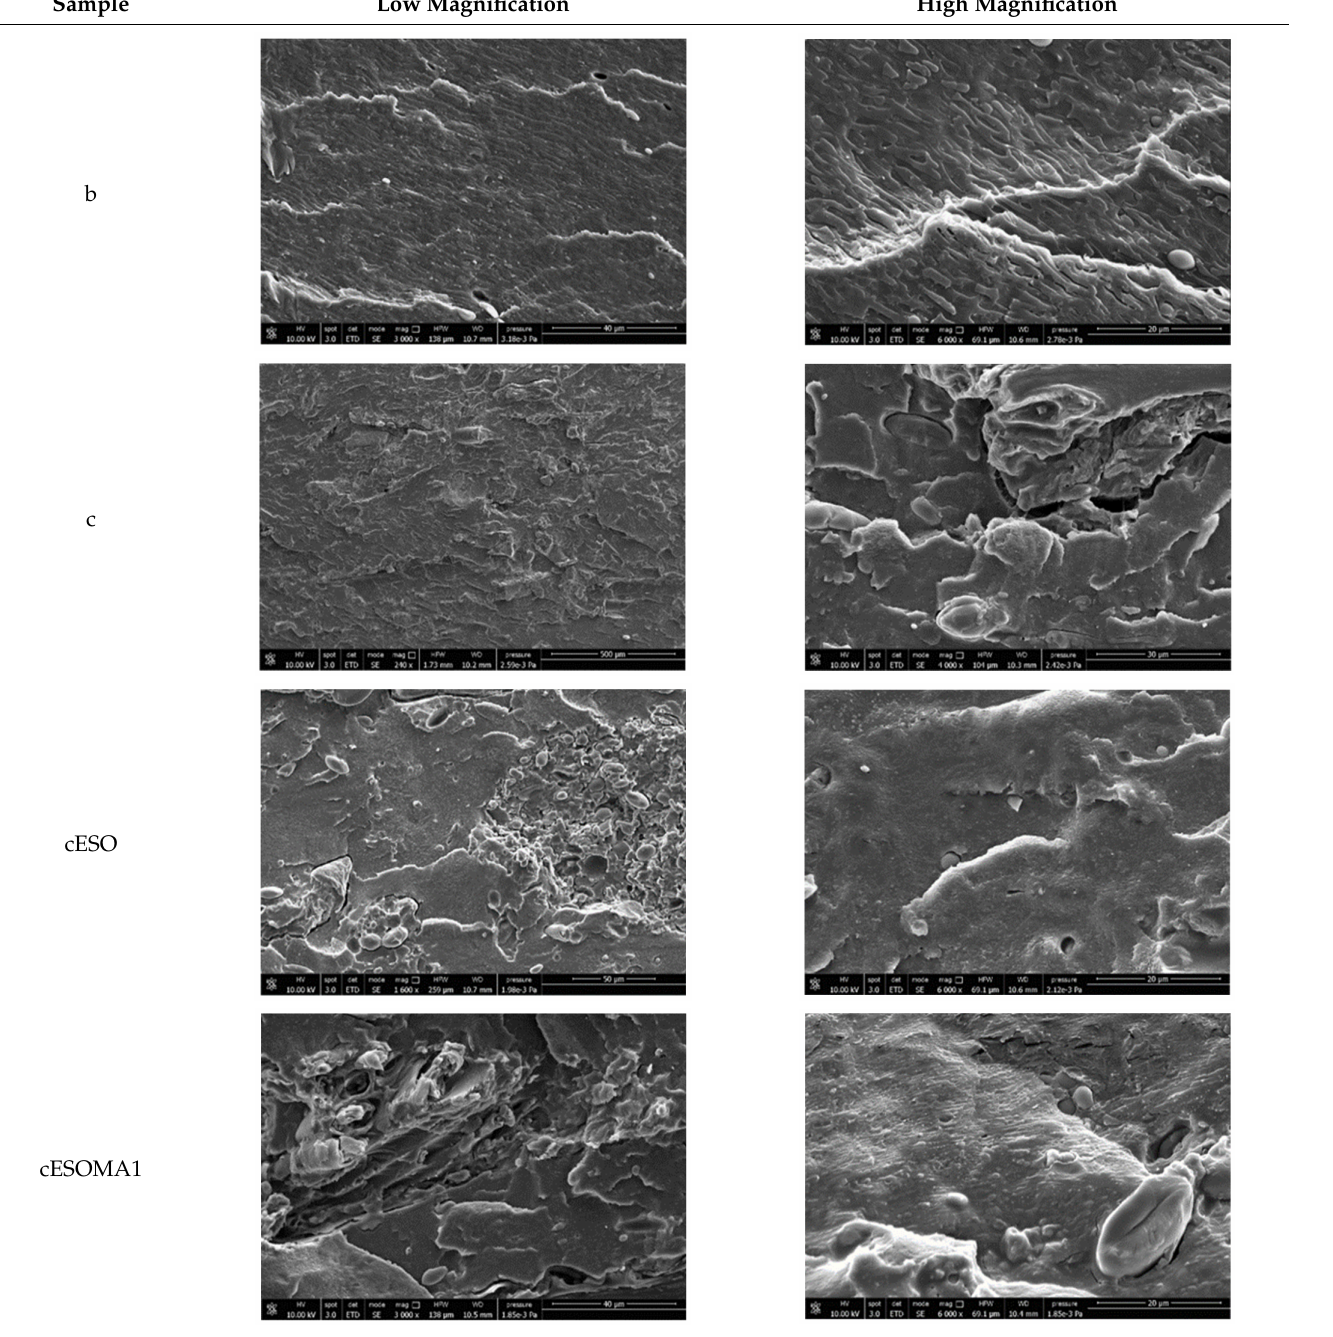
Table 8. Comparison between SEM images of b, c, cESO, cESOMA1, cESOSA1, and cJONCRYL formulations: low magnification factor (left) versus high magnification factor